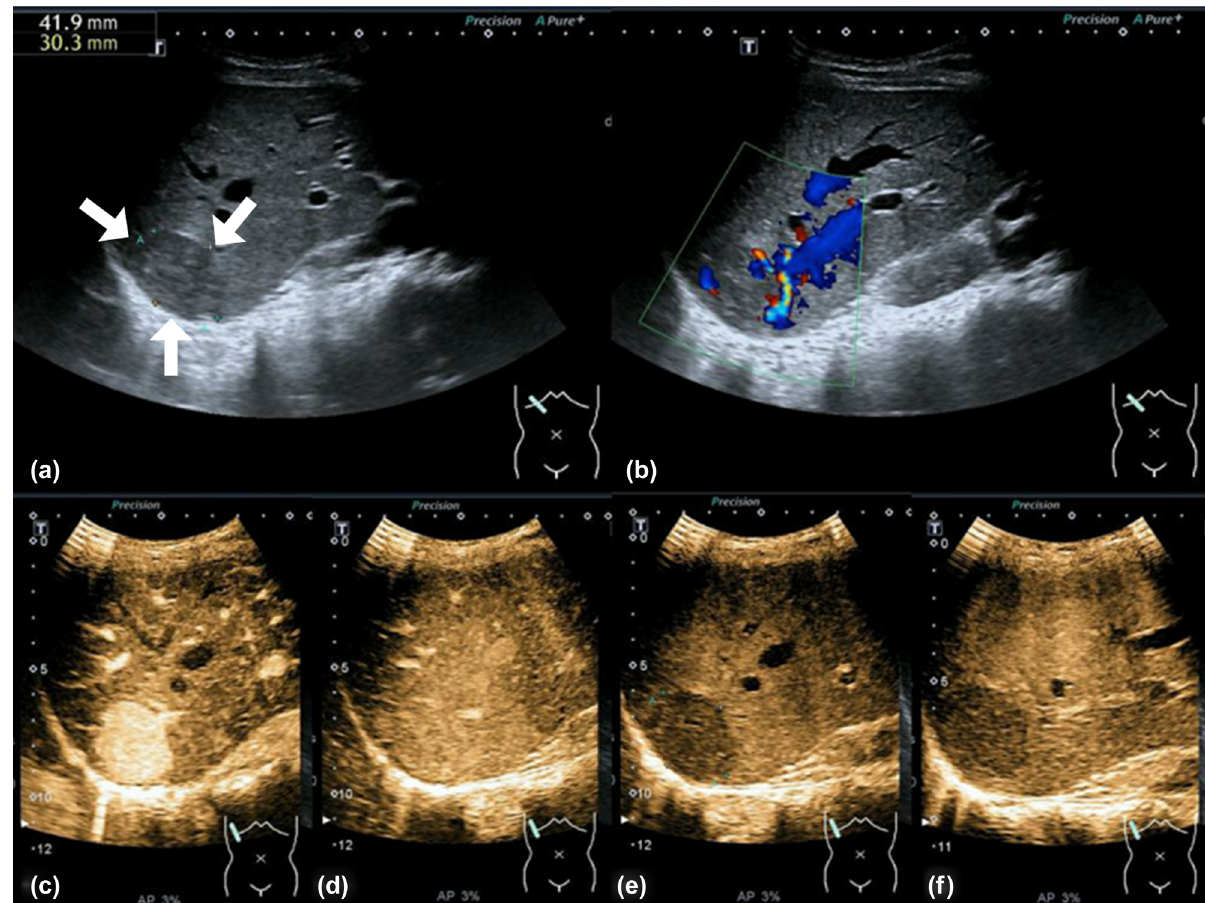
Figure 1: Abdominal ultrasonography and Sonazoid contrast - enhanced ultrasound images ( Sonazoid 0.5 mL bolus injection, Toshiba Aplio 500, and 3.75 MHz convex array probe ) of a primary hepatic perivascular epithelioid cell tumor. ( a ) A heterogeneous hypoechoic nodule is demonstrated on B - mode ultrasound ( arrows ) . ( b ) Color Doppler fl ow images reveal abundant blood fl ow at the tumor margins. ( c – f ) Sonazoid contrast - enhanced ultrasound in the arterial ( c, 23 s ) , portal ( d, 100 s ) , equilibrium ( e, 5 min ) , and post - vascular ( f, 10 min ) phases. Hyper - enhancement is observed in the arterial phase, with iso - enhancement in the portal phase and mild hypo - enhancement in the equilibrium and post - vascular phases.